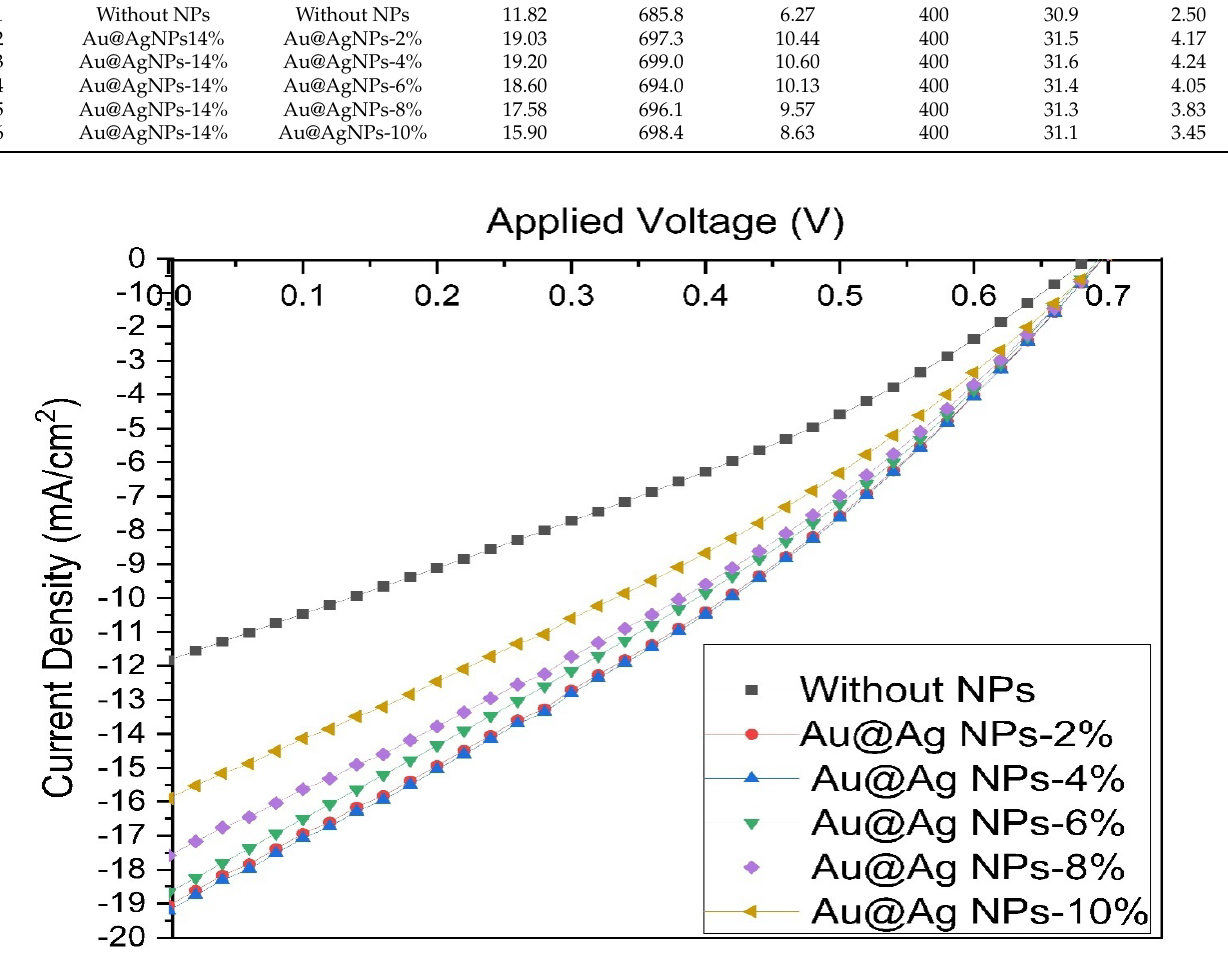
Figure 6. J-V curve of PSCs (ITO/PEDOT: PSS+Au@Ag NPs-14%/PTB7:PC71BM+ different amount of Au@Ag NPs). Table 1. Electrical parameters of the PSCs with and without NPs. Table 2. Summary of previous research on plasmonic MNPs and their corresponding PCE